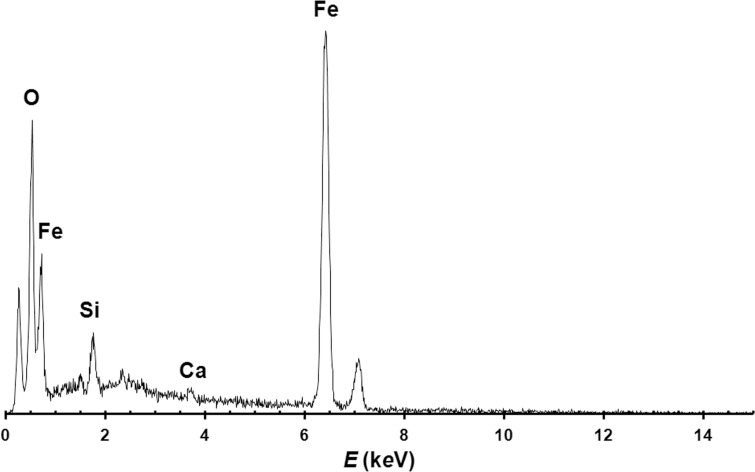
EDS spectrum of the red coating on one of the stone flakes.